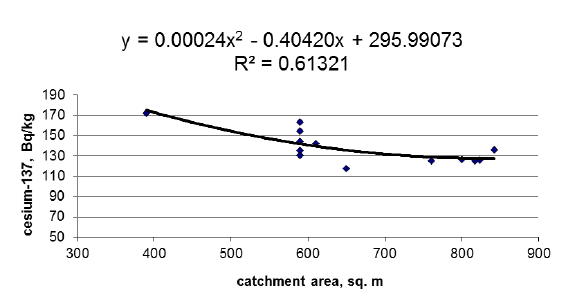
Figure 4. Relationship function for the short modern streams (lengths up to 150 m and catchment areas up to 1000 sq. m), correlation coefficient is